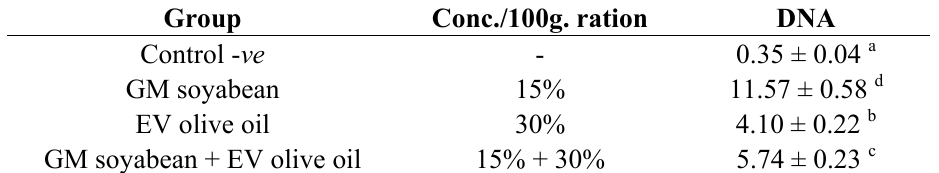
Table 4. Effect of E.V.olive oil and G.M. soyabean on DNA (ng/g spleen). Significant at p < 0.05 using ANOVA test a, b, c,… Significantly different between two comparison groups within the same litter and column using Duncan Multiple Range test at p <